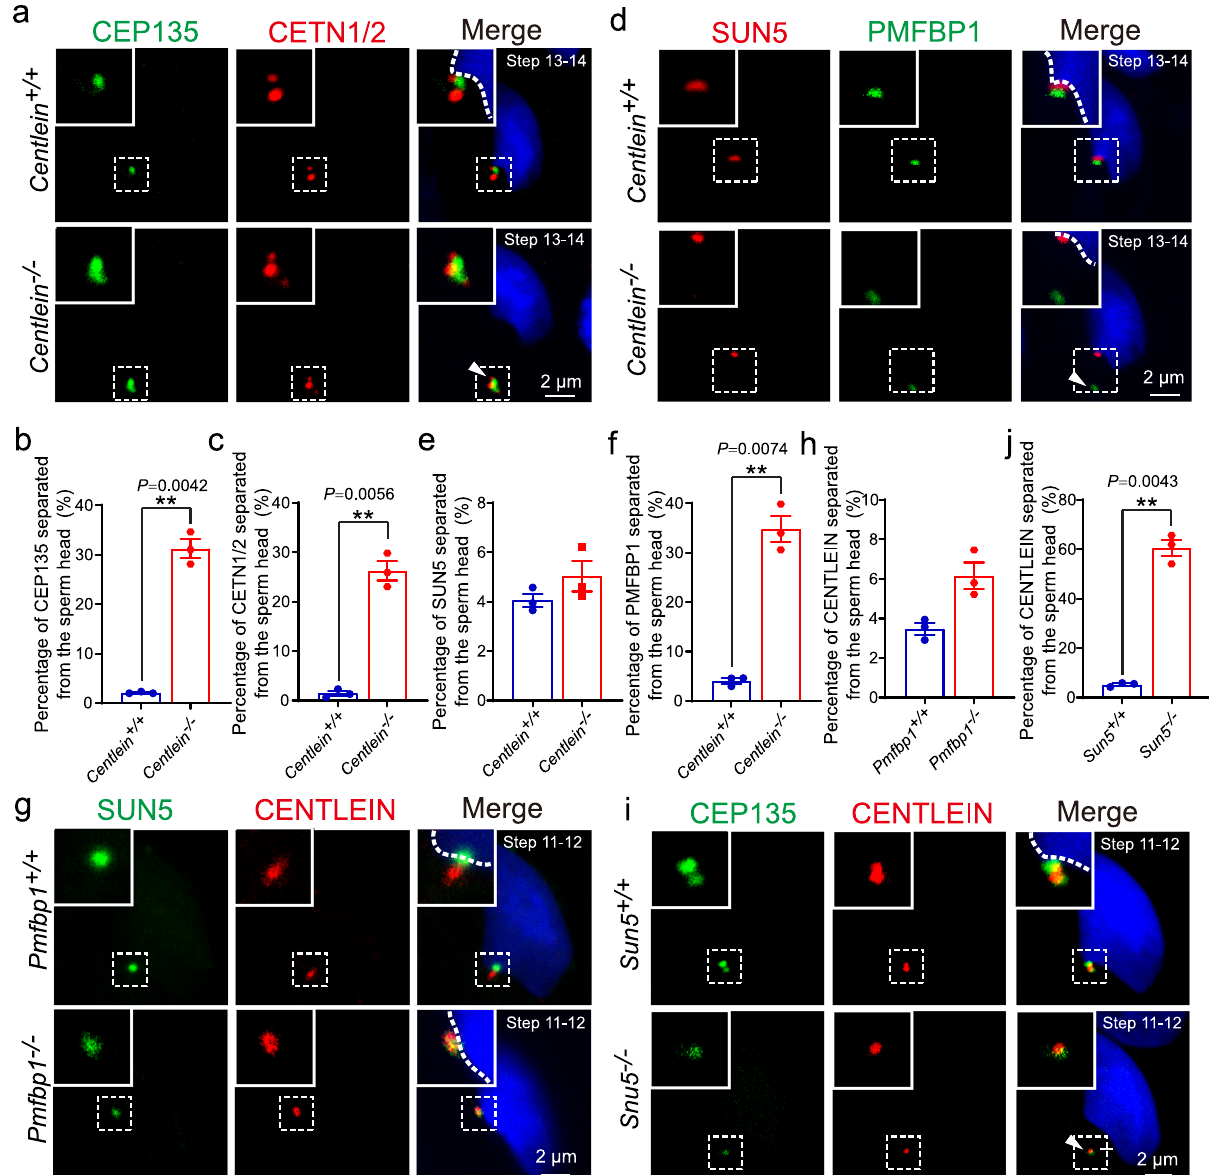
Fig. 7 CENTLEIN cooperates with SUN5 and PMFBP1 to connect the sperm tail to its head. a Immuno fl uorescence analysis for CEP135 (green) and CETN1/2 (red) was performed in Centlein + / + and Centlein − / − testicular germ cells. Nuclei were stained with DAPI (blue). The arrow head indicates detached CEP135 and CETN1/2 from sperm head. b , c Quanti fi cation ratio of CEP135 ( b ) and CETN1/2 ( c ) separated from the sperm head >1.5 μ m in Centlein + / + and Centlein − / − mice ( n = 3 independent experiments). Blue dots indicate Centlein + / + mice and red dots indicate Centlein − / − mice. d Ablation of Centlein impairs the localization of PMFBP1 to the coupling apparatus. Immuno fl uorescence analysis for PMFBP1 (green) and SUN5 (red) was performed in Centlein + / + and Centlein − / − testicular germ cells. Nuclei were stained with DAPI (blue). The arrow head indicates detached PMFBP1 from sperm head. e , f Quanti fi cation ratio of SUN5 ( e ) and PMFBP1 ( f ) separated from the sperm head >1.5 μ m in Centlein + / + and Centlein − / − mice ( n = 3 independent experiments). Blue dots indicate Centlein + / + mice and red dots indicate Centlein − / − mice. g Disruption of Pmfbp1 has no in fl uence on the localization of CENTLEIN to the coupling apparatus. Immuno fl uorescence analysis for CENTLEIN (red) and SUN5 (green) was performed in Pmfbp1 + / + and Pmfbp1 − / − testicular germ cells. Nuclei were stained with DAPI (blue). h Quanti fi cation ratio of CENTLEIN separated from the sperm head >1.5 μ m in Pmfbp1 + / + and Pmfbp1 − / − mice ( n = 3 independent experiments). Blue dots indicate Pmfbp1 + / + mice and red dots indicate Pmfbp1 − / − mice. i Lack of Sun5 perturbs the localization of CENTLEIN to the coupling apparatus. Immuno fl uorescence analysis for CENTLEIN (red) and CEP135 (green) was performed in Sun5 + / + and Sun5 − / − testicular germ cells. Nuclei were stained with DAPI (blue). The arrow head indicates detached CENTLEIN and CEP135 from the sperm head. j Quanti fi cation ratio of CENTLEIN separated from the sperm head >1.5 μ m in Sun5 + / + and Sun5 − / − mice ( n = 3 independent experiments). Blue dots indicate Sun5 + / + mice and red dots indicate Sun 5 − / − mice. Data in b , c , e , f , h , j are presented as mean ± SEM. A two-tailed Student ’ s t test was performed, ** P <